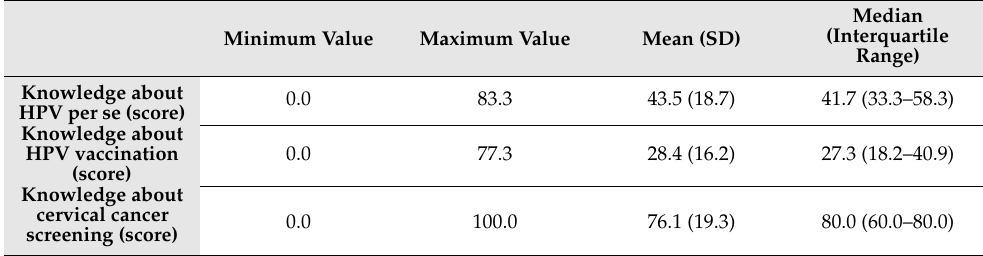
Table 2. Descriptive statistics of knowledge score about HPV, HPV vaccination, and cervical cancer screening.